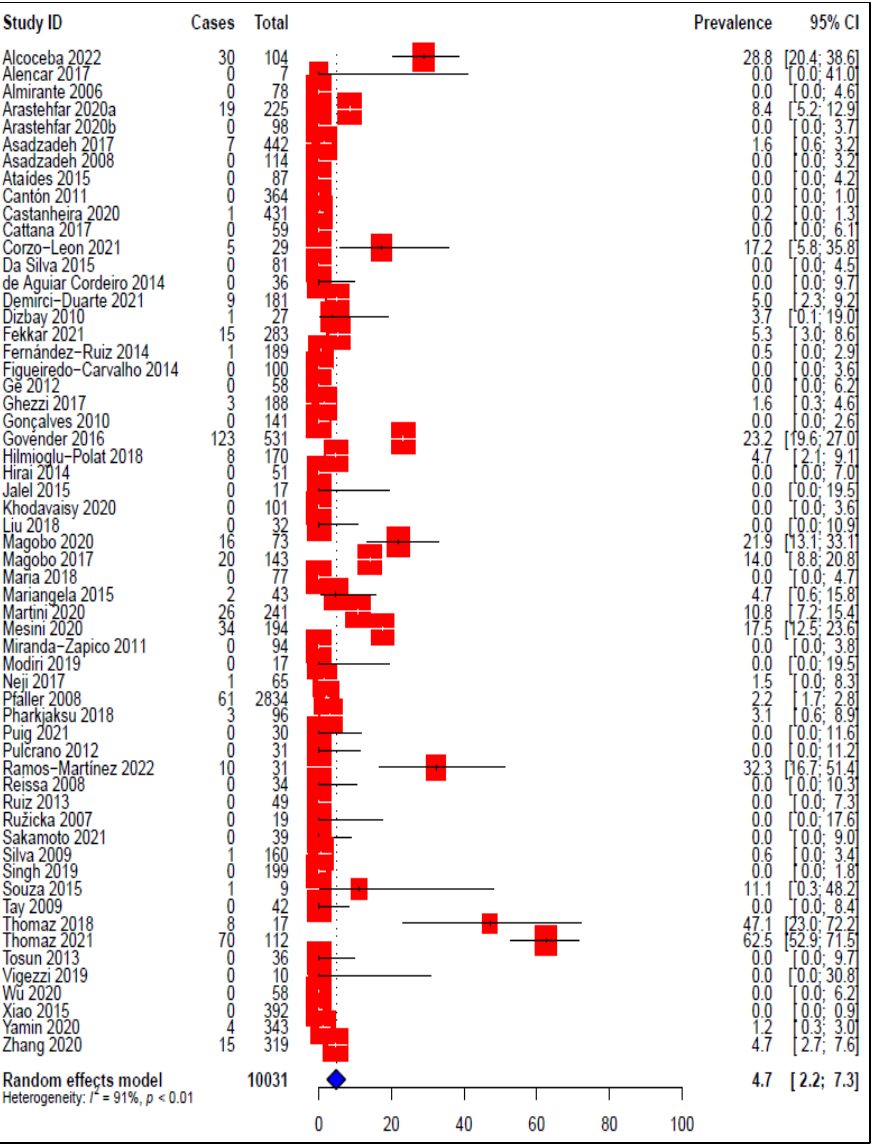
Figure 4. Forest plot representing the pooled prevalence of Voriconazole-Resistant Candida parapsilosis